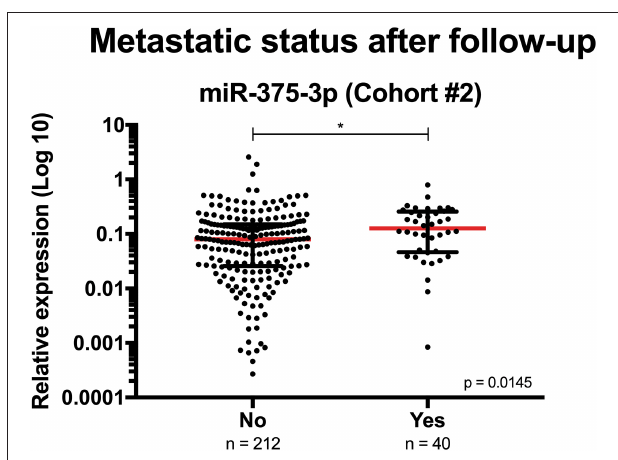
FIGURE 3 | Circulating miR-375-3p’s expression levels at diagnosis according to metastatic status after follow-up (Cohort #2). Mann-Whitney U , * p < 0.05. Red horizontal line represents the relative expression levels’